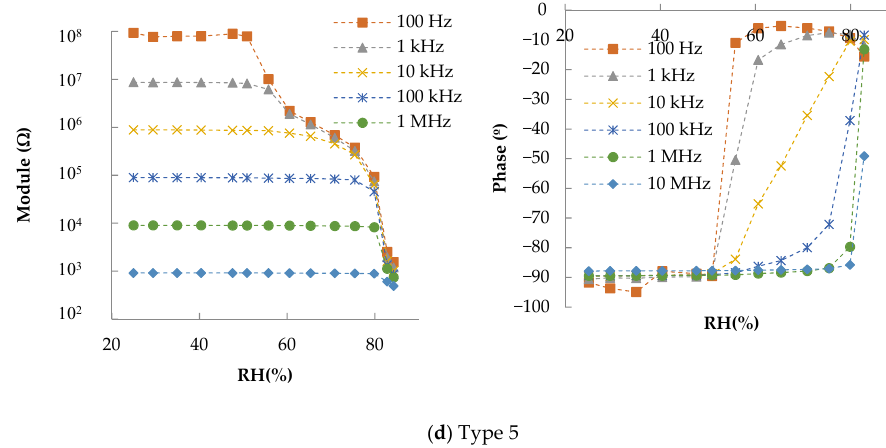
Figure A1. Impedance response towards RH at 40 °C for different operating frequencies for sensors with interspacing of 300 µm: ( a ) type 2; ( b ) type 3; ( c ) type 4; ( d ) type 5. Module is depicted in the left column and phase in the right one.